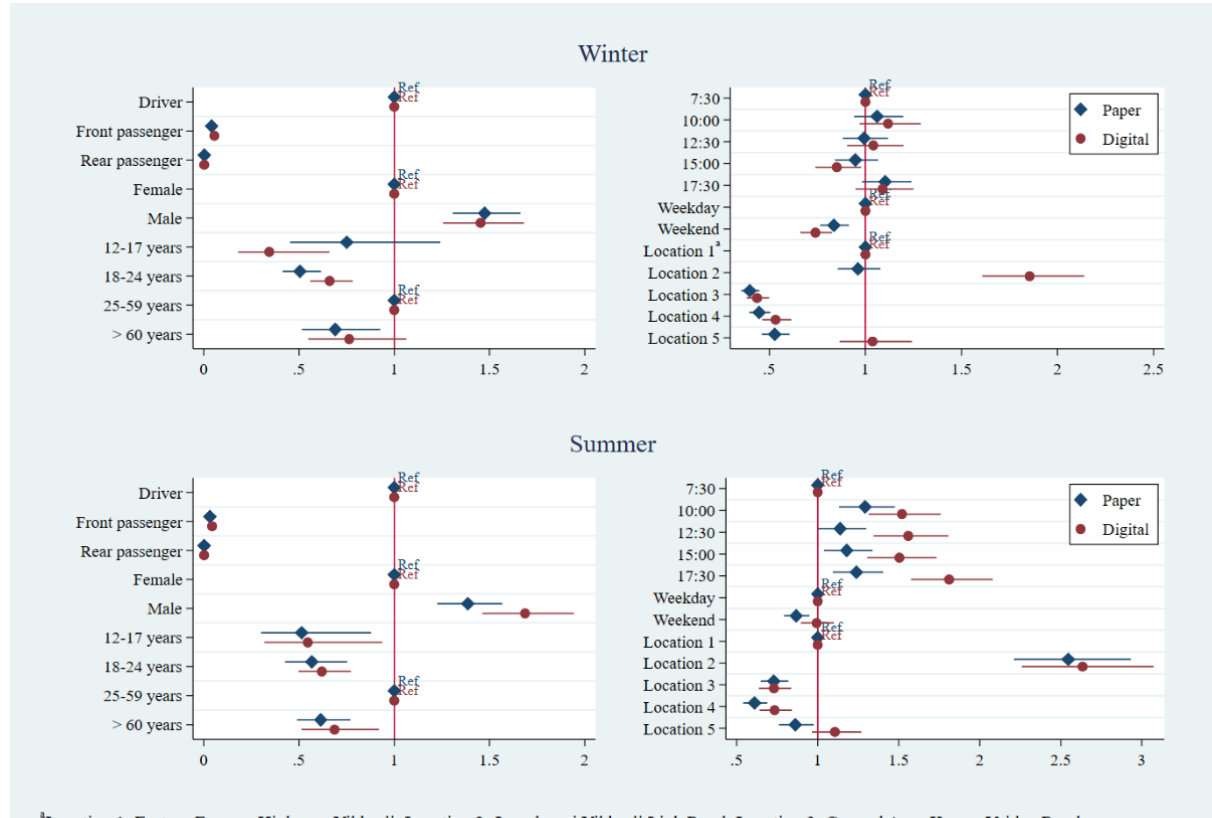
Figure 5. Seatbelt use: adjusted odds ratios by data collection method and